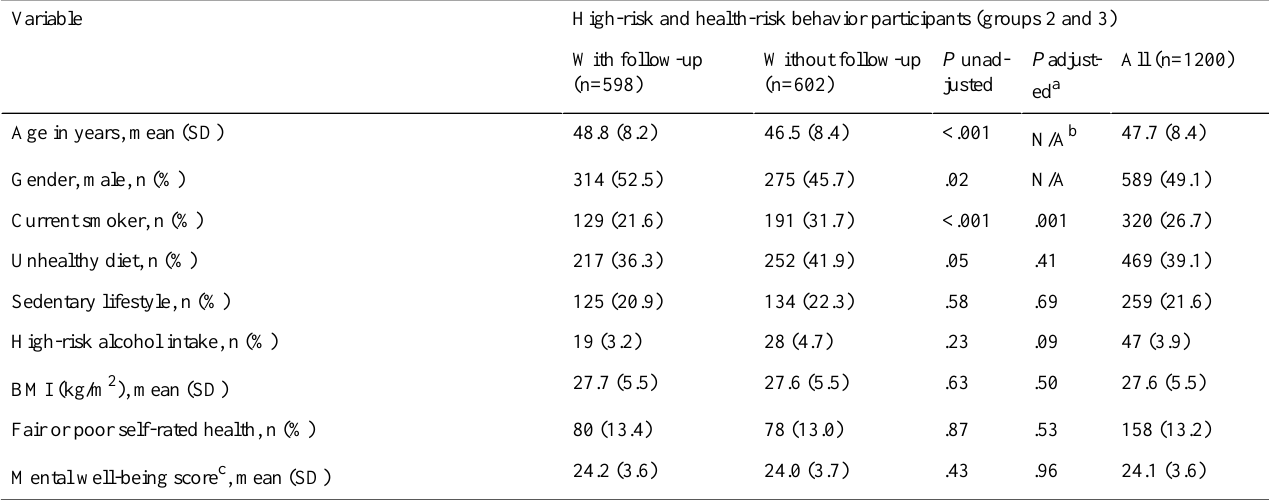
Table 2. Baseline characteristics among high-risk and health-risk behavior participants with and without 1-year follow-up (n=1200). High-risk and health-risk behavior participants (groups 2 and 3)Variable